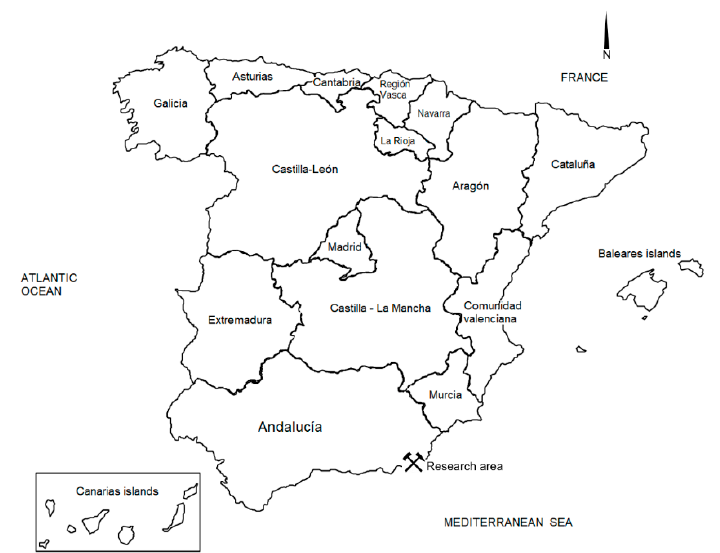
Figure 1. Geographic location map.